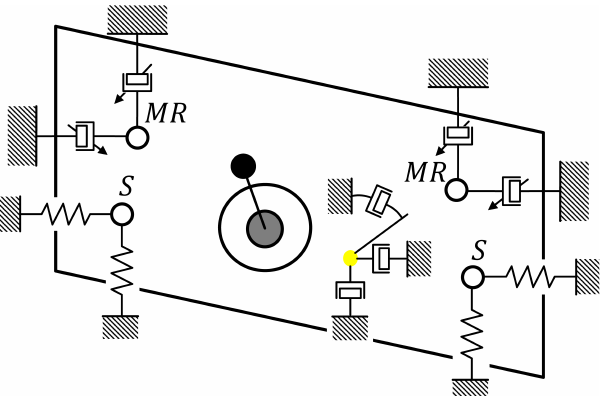
Figure 17. Mechanical representation of the dynamic model of the vibrating screen, including the Bouc–Wen model of the MR damper.